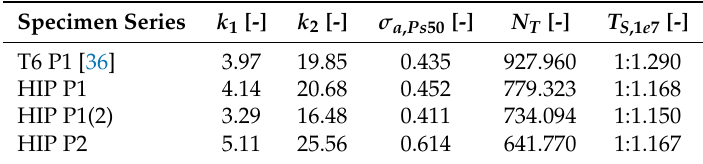
Table 4. Evaluated results of the fatigue tests of the investigated specimen series. Specimen